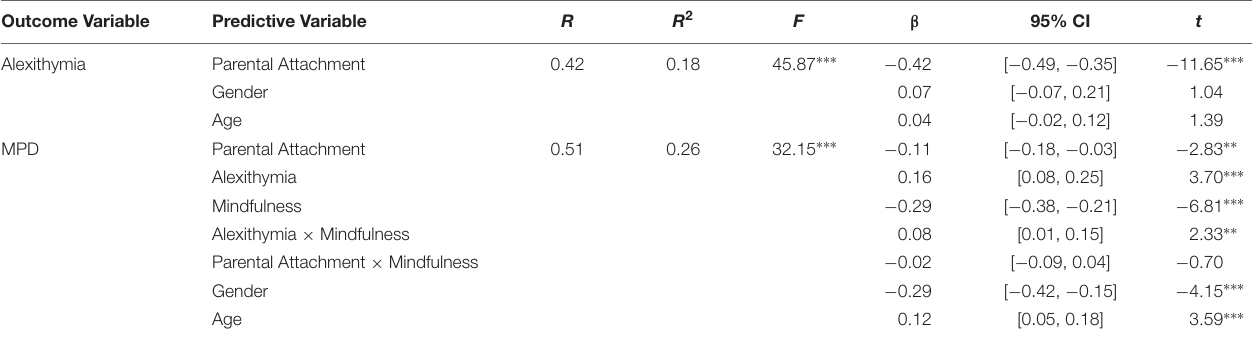
TABLE 2 | The moderated mediation model ( N